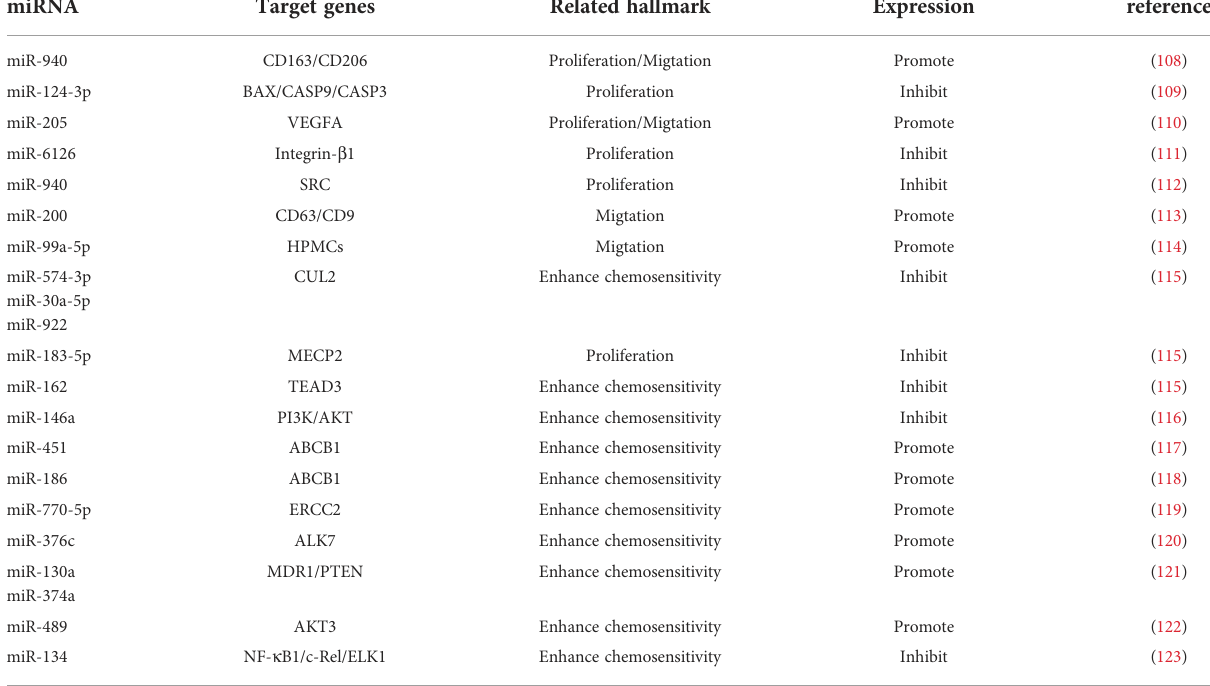
TABLE 2 Details of exosome-derived miRNAs targeting the TME to regulate ovarian cancer.